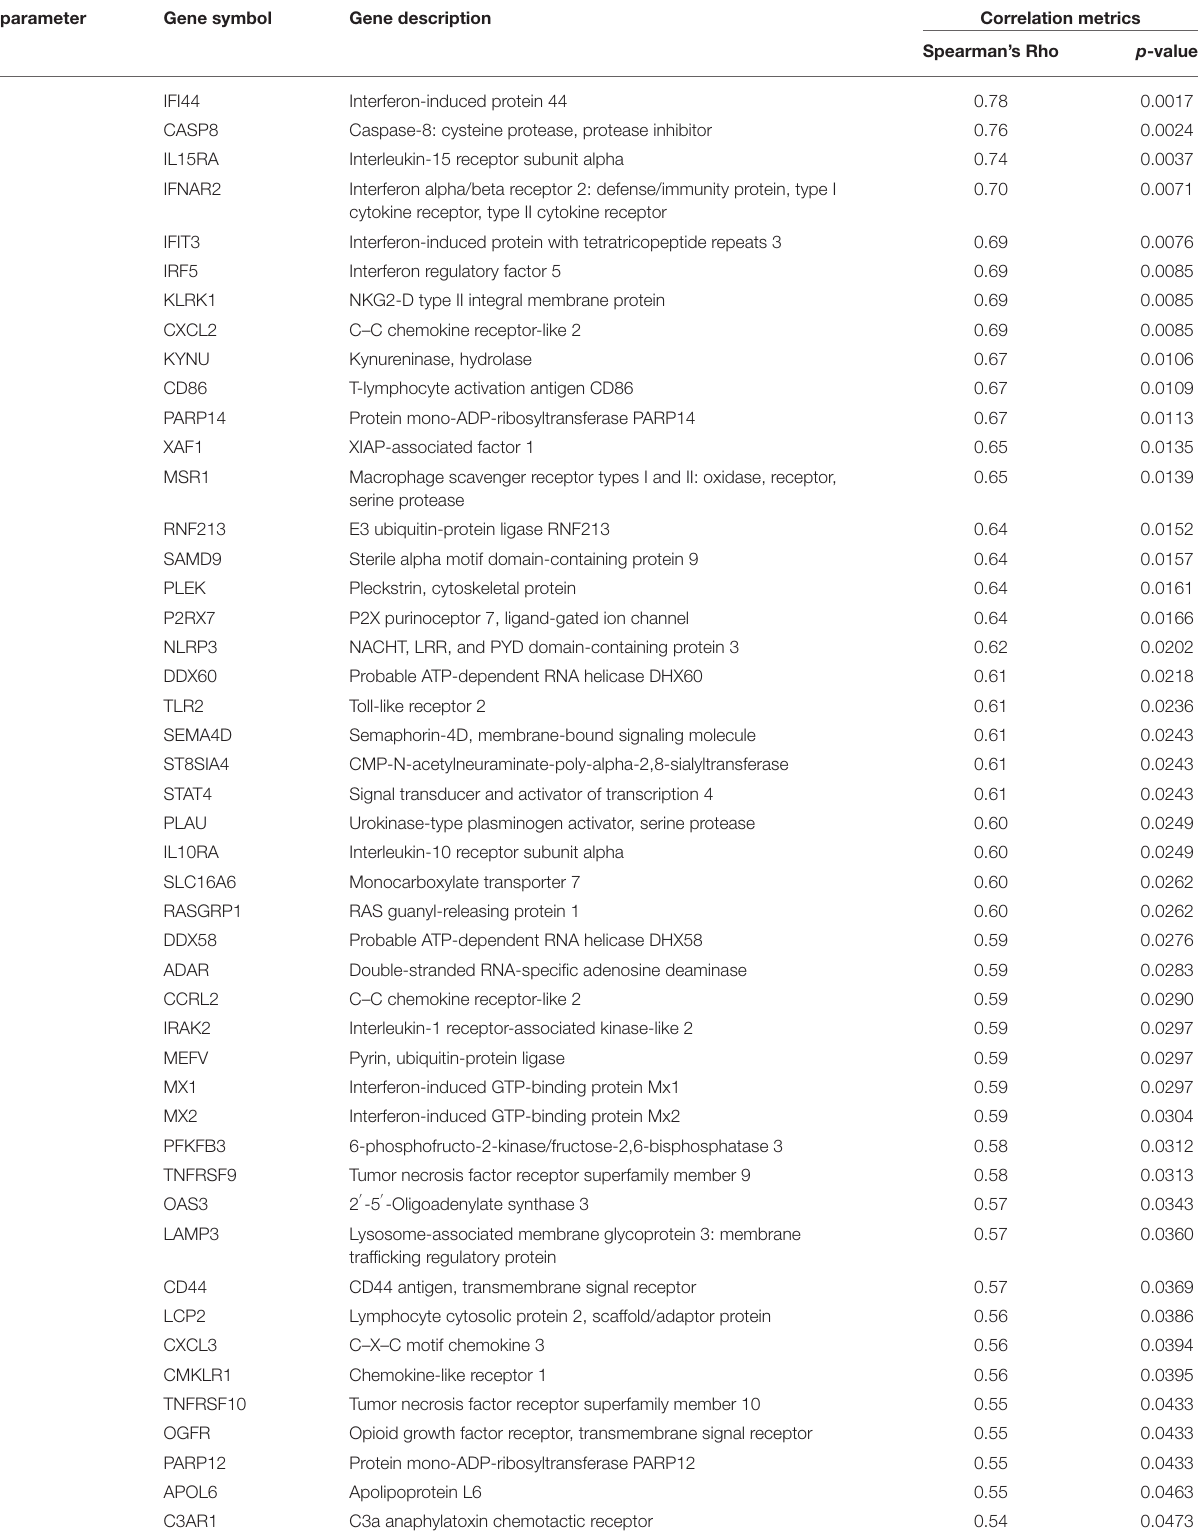
TABLE 5 | Gene expression (FPKM) correlations with clinical parameters of disease activity. Clinical parameter Gene symbol Gene description Correlation